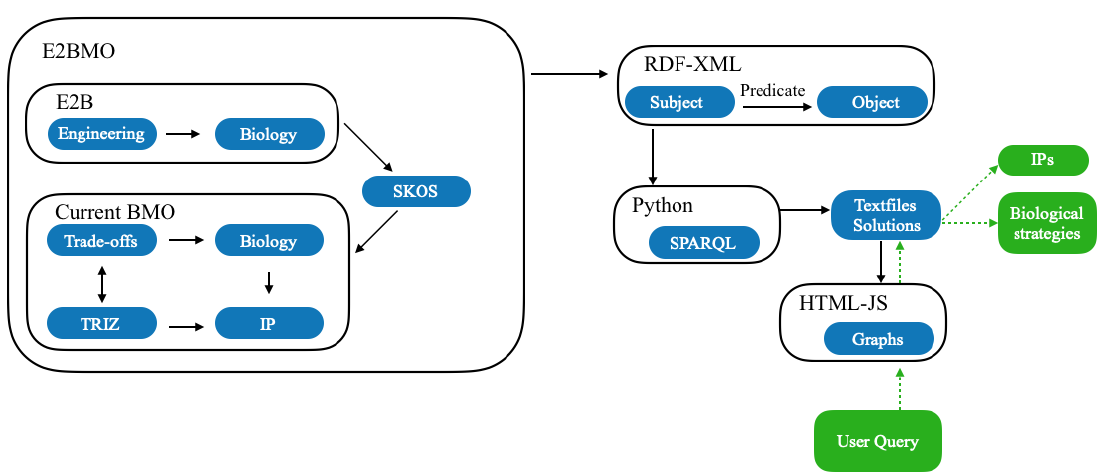
Figure 4. Green boxes present the user interaction with E2BMO and blue boxes are the underlying building blocks of E2BMO. building blocks of